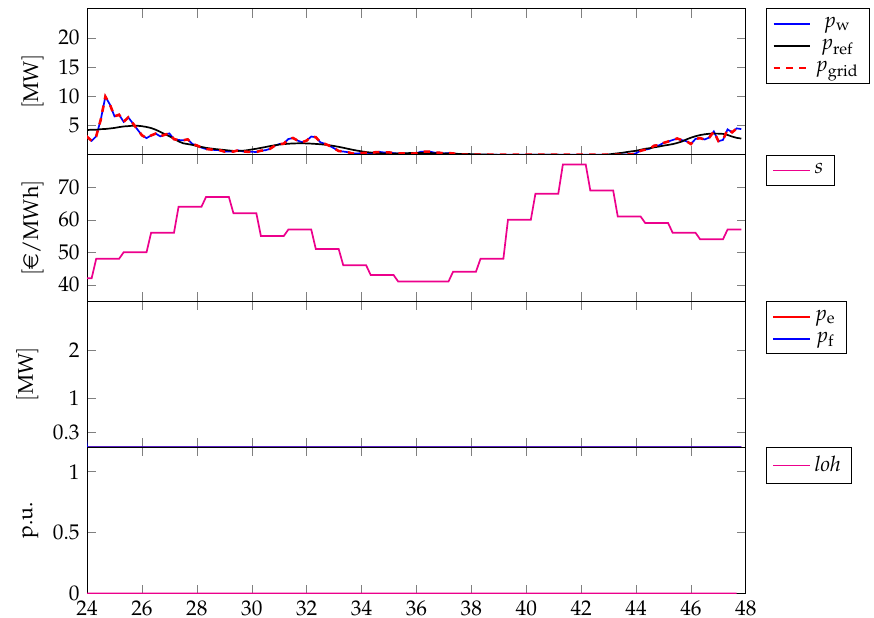
Figure 7. Different profiles related to the reference period 14:40 of 19 February 2017 to the same hour of 20 February 2017, for highlighting the impact of c fee . First graph: power by wind generation (blue line), power reference that has to be delivered to the grid (black line) and actual power delivered (dashed red line); Second graph: spot market prices s (source: “Gestore dei Mercati Energetici s.p.a. — www.mercatoelettrico.org”); Third graph: power of the electrolyzer (red line) and power of the fuel cell (blue line); Fourth graph: LoH.